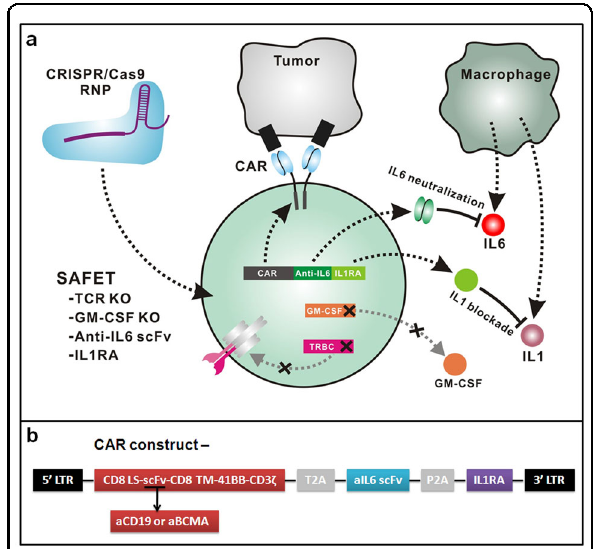
Fig. 1 The design of SAFET platform for CART cell therapy. a Scheme of CRISPR-edited GM-CSF KO CART cells secreting IL6 and IL1 blockers. Patient-derived T cells were engineered with CRISPR/Cas9 RNP for GM-CSF/TCR KO and transduced with lentivector encoding 2nd generation 41BB ζ CAR and anti-IL6 scFv and IL1RA for blocking IL6/IL1 signalings. b The construct of lentivector for co-expressing CAR and cytokine